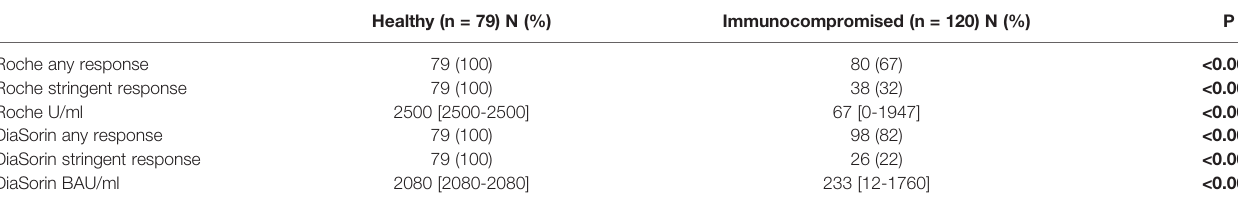
TABLE 2 | Antibody Response to